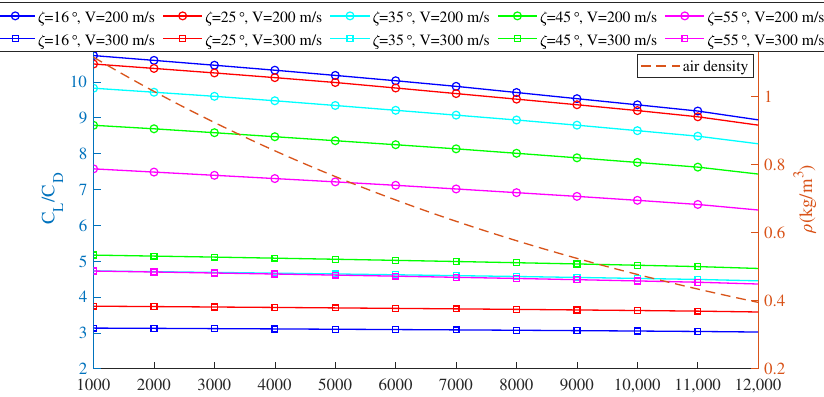
Figure 7. The variation in the C L / C D with respect to altitude. It can be seen in Figure 7 that the lift-to-drag ratio decreases slightly with increasing altitude. The variation in the air density with the altitude is more significant than that in the lift-drag ratio, and this relationship is estimated as ρ ( h ) = ρ 0 exp ( h / h s ) [27], where = 9.43 × 10 − 5 is the air-density ρ 0 = 1.225 is the nominal air density at sea level and h − 1 s decay rate. Obviously, the variation in altitude causes changes in the aerodynamic coeffi- cient and air density at the same time; among them, the latter has a more significant effect on the dynamic characteristics of the